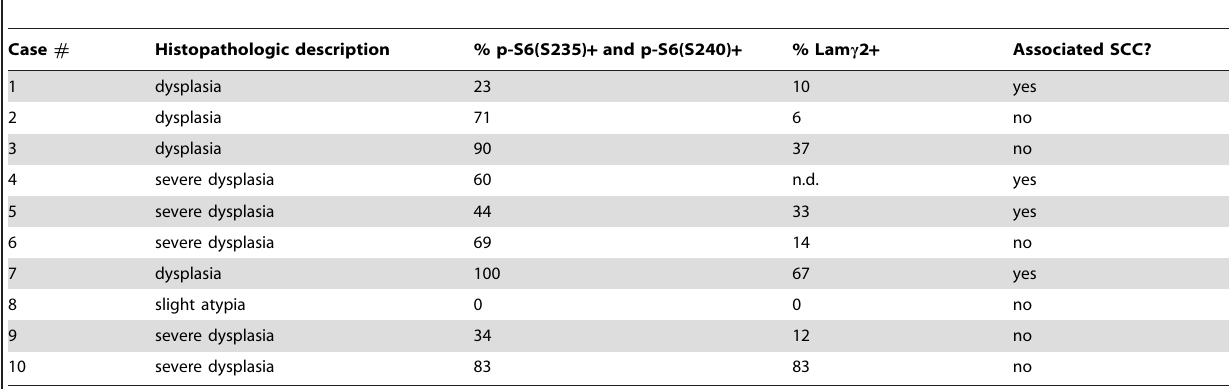
Table 1. Human oral epithelial lesions examined for increased p-S6 and Laminin c 2 by immunohistochemical